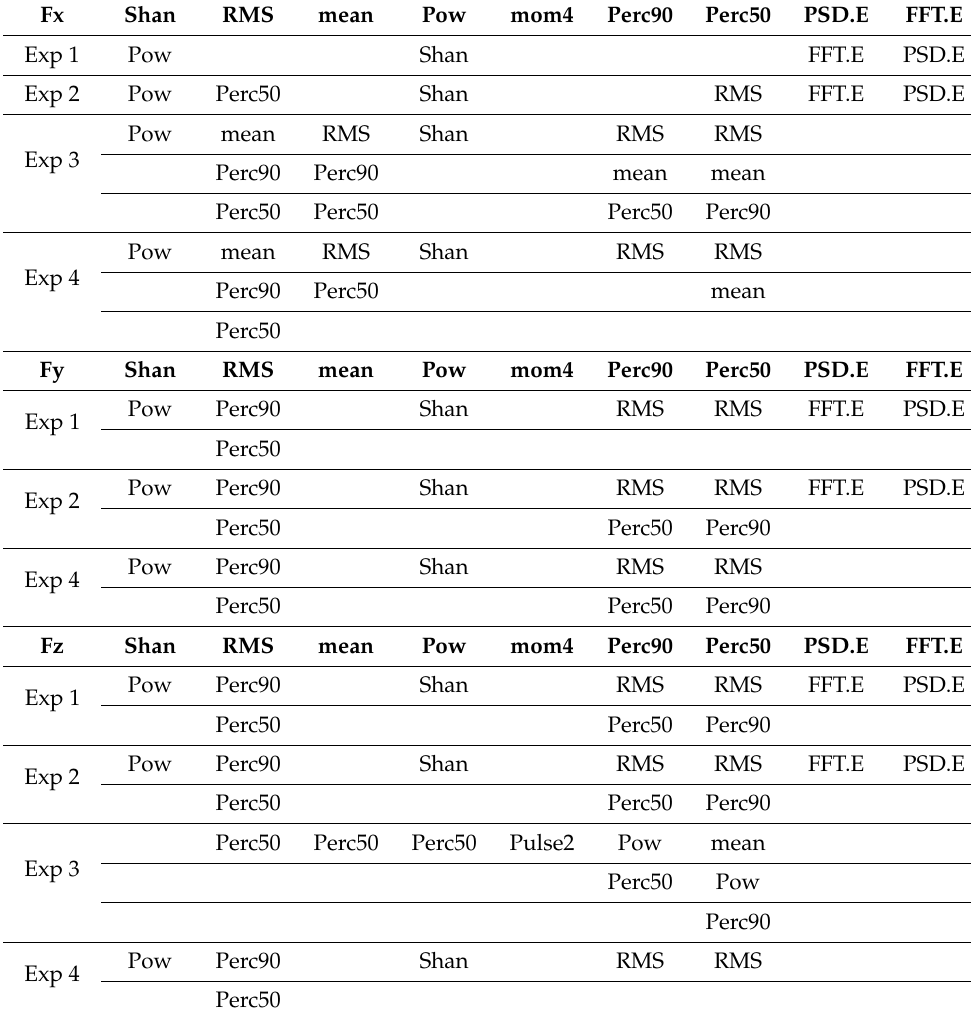
Table 6. Cross correlated SFs for machining force